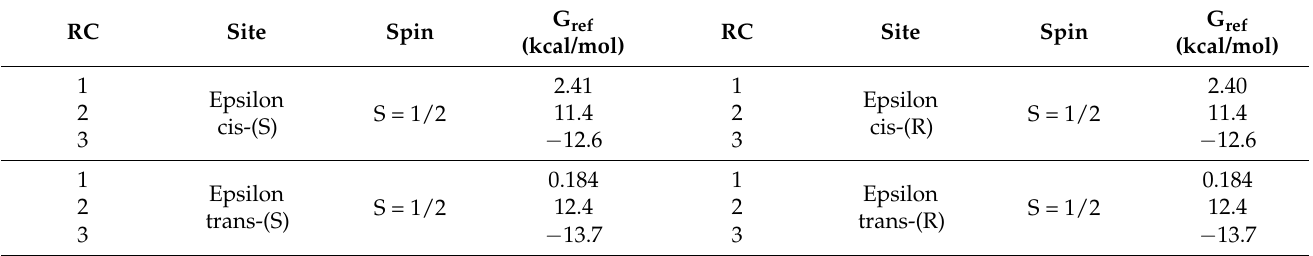
Figure 2. DFT/LAN level-optimized transition state structures for the hydrogen transfer to CYP through the cis reaction path in the doublet state for the R and S α -pinene enantiomers. Table 3. Gibbs free energy coordinates of the reaction R/S and cis/trans paths for the α -pinene. Data are provided in kcal/mol and relative to the most stable structure formed in reaction coordinate 1, the gamma conformer. RC is reaction